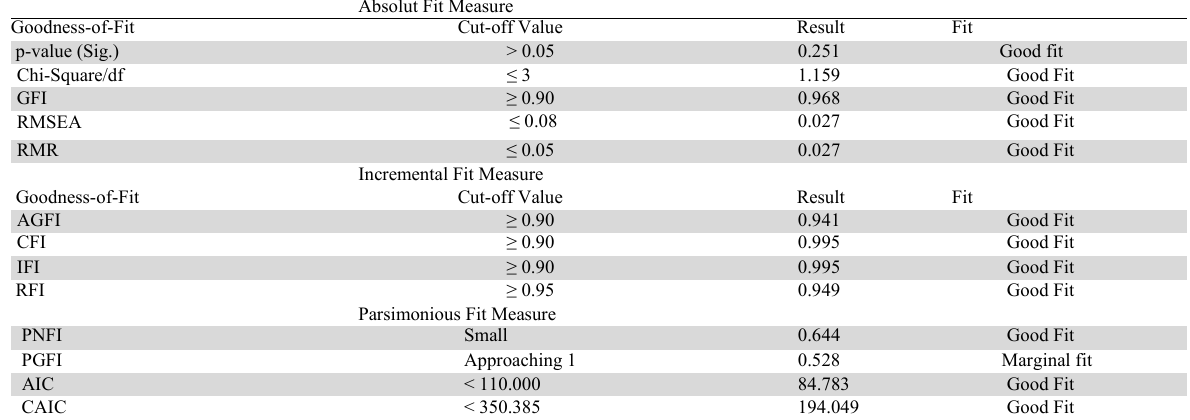
Goodness of Fit of Confirmatory Factor Analysis (CFA) Model of Withdrawal Behavior (Y)